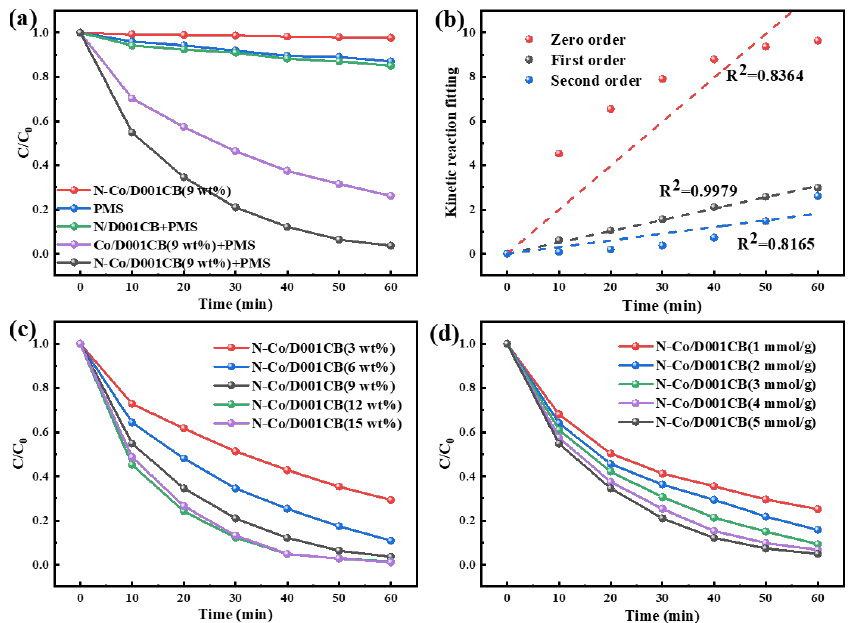
Figure 5. The removal of ibuprofen with different reaction systems ( a ); kinetic fitting curve of N-Co/D001CB + PMS reaction system ( b ); cobalt loading amount ( c ); dicyandiamide amount ( d ); (Temperature = 25 °C, pH = 4.5, PMS = 0.7 mM, amount of catalyst added = 0.3 g/L, IBU = 10 mg/L).